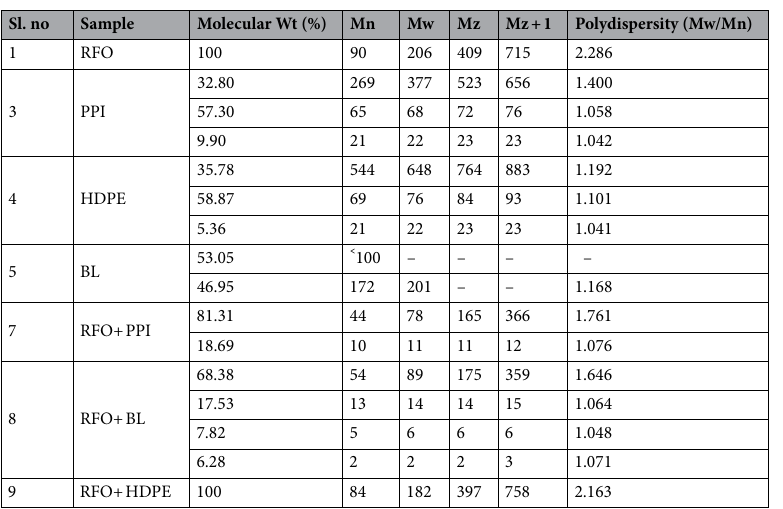
Table 1. Molecular weight distribution of liquid products obtained from the co-cracking of RFO and Plastics. Mn number average molecular weight, Mw weight average molecular weight, Mz average molecular weight, Mw/Mn polydispersity, Mz + 1 average molecular